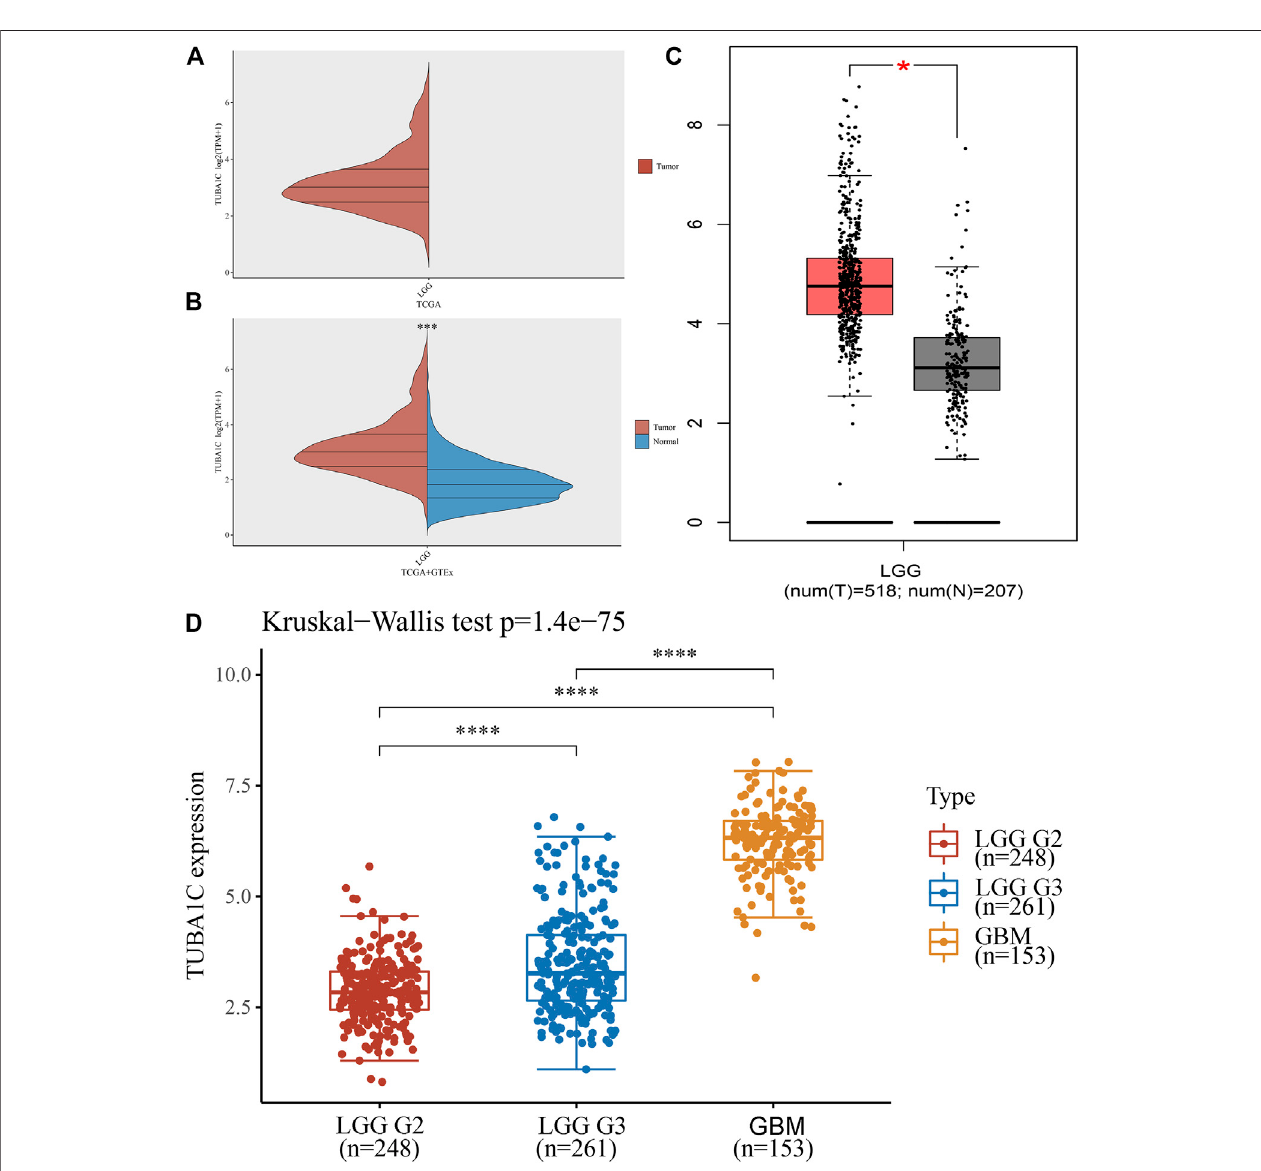
FIGURE 1 | The different mRNA expressions of TUBA1C in LGG, GBM, and normal tissues. (A , B) mRNA expressions of TUBA1C in LGG and normal tissues. (C) mRNA expression of TUBA1C in LGG and normal tissues in the GEPIA. (D) Differential TUBA1C expressions in tumor stages in LGG and GBM. * p < 0.05, *** p < 0.001, **** p <